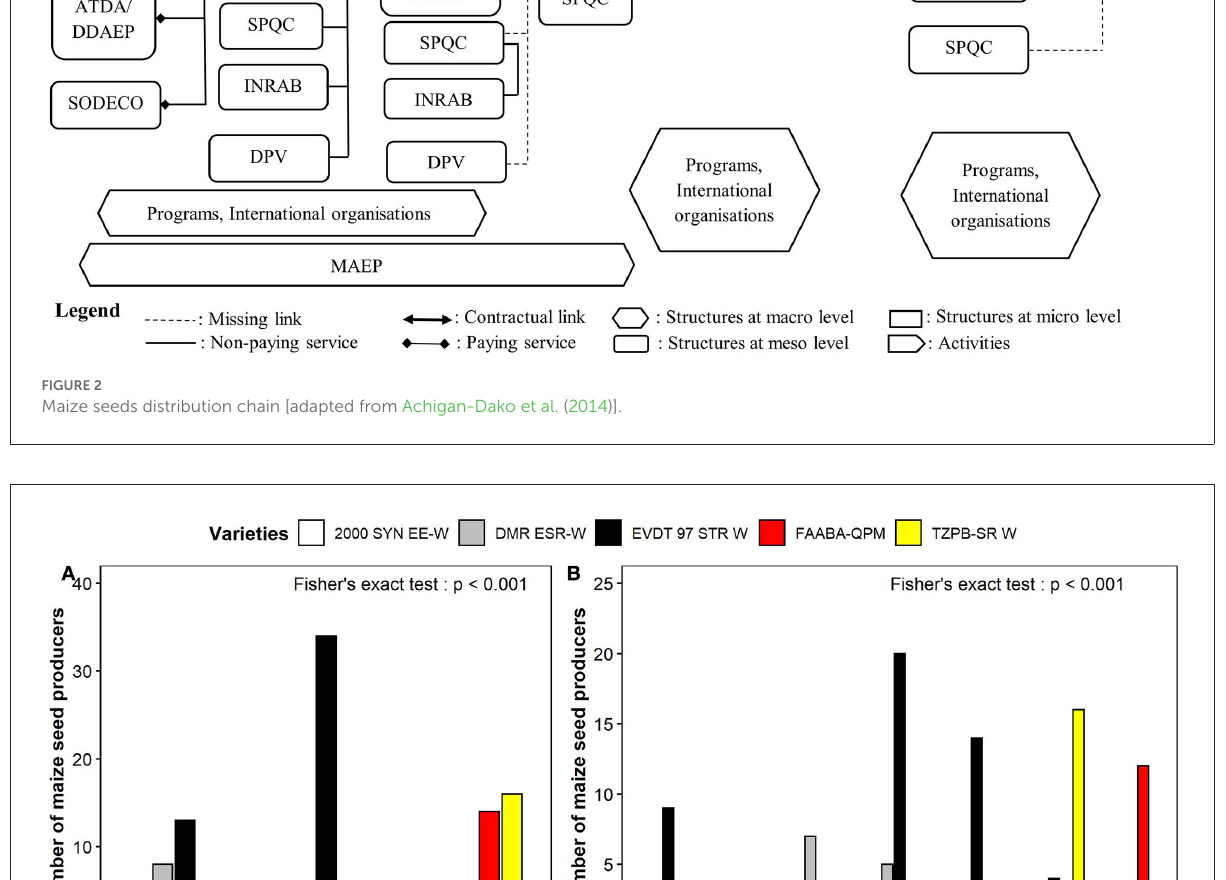
producers) are practiced and depend on the phytogeographical zone (Fisher’s exact, p < 0.001, Figure 5A). Cropping area under maize seed production varied significantly